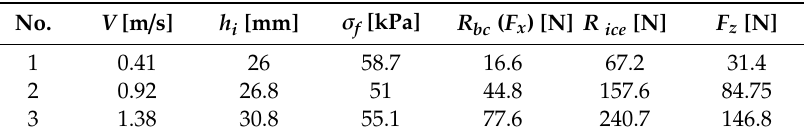
Table 3. Model test conditions.